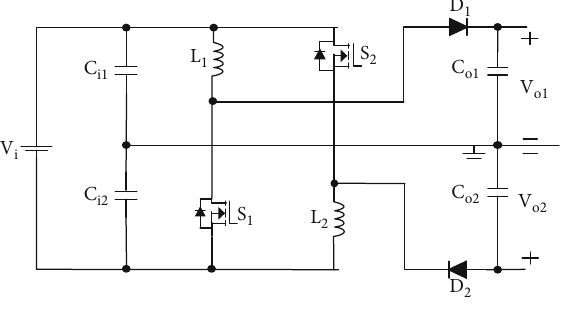
Figure 2: The proposed